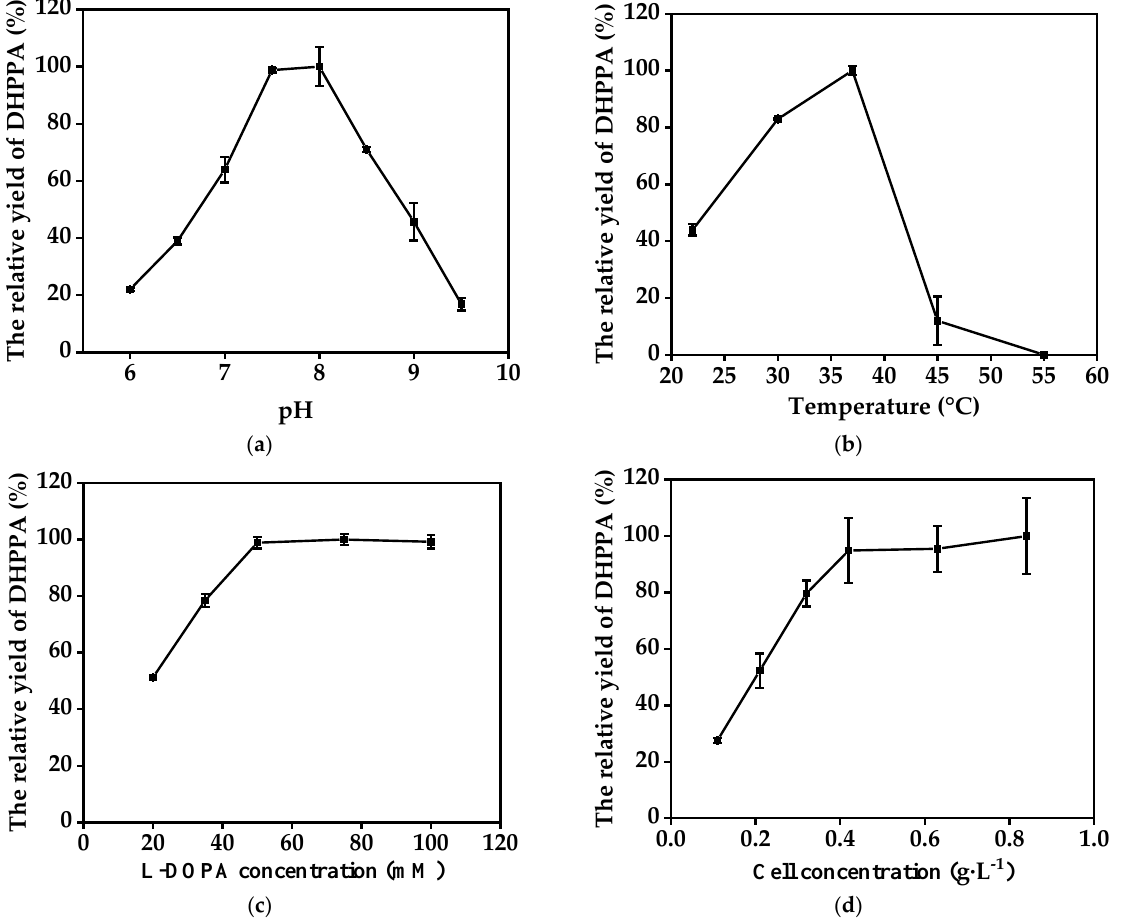
Figure 3. ( a ) Effects of pH on the relative yield of DHPPA (reactions were performed at 37 ◦ C in reaction mixture comprised of 0.42 g · L − 1 recombinant cells and 20 mM L -DOPA (pH 5–10); the DHPPA yield at pH 7.5 was set as 100%); ( b ) effects of temperature on the relative yield of DHPPA (reactions were performed at 22–55 ◦ C in reaction mixture comprised of 0.42 g · L − 1 recombinant cells and 20 mM L -DOPA (pH 7.5); the DHPPA yield at 37 ◦ C was set as 100%); ( c ) effects of